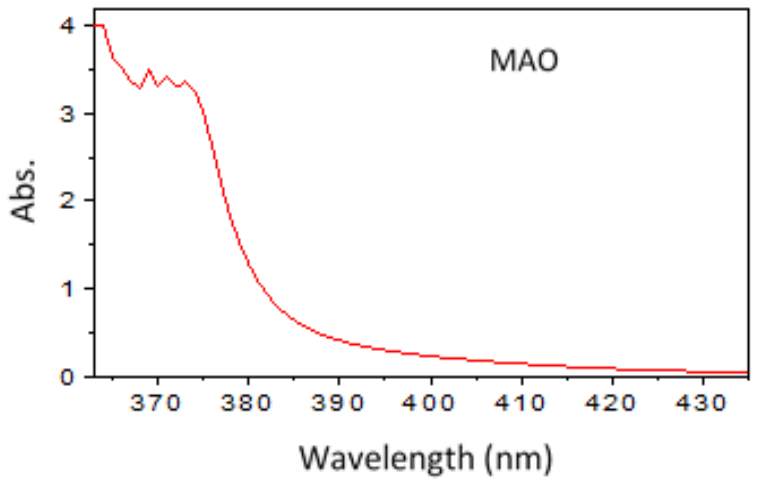
Figure 1. UV–visible spectrum of the utilized inhibitor, N,N’-bis[2-methoxynaphthylidene]amino]oxamide (MAO), in dimethylformamide (DMF).